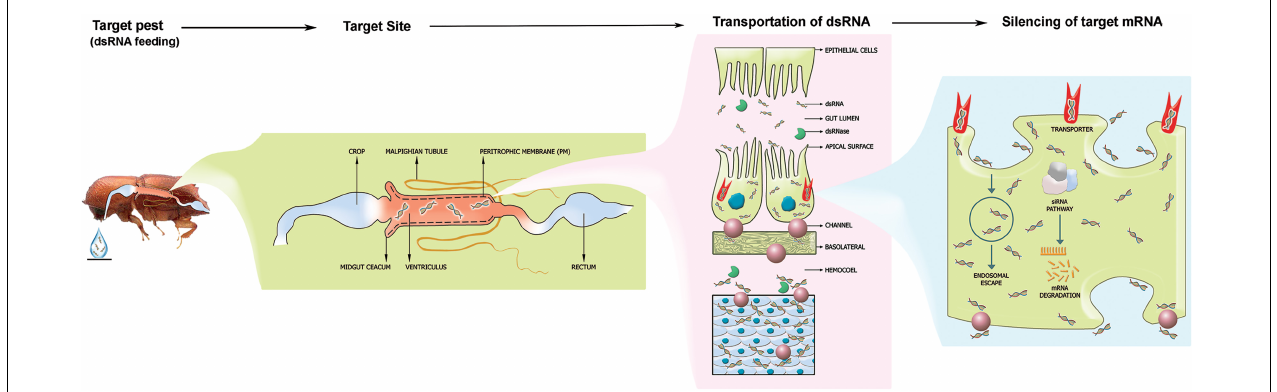
FIGURE 1 | The fundamental mechanism of RNAi from a coleopteran pest control standpoint. The target pest is feeding on the species-specific, gene-specific dsRNA droplet. After ingestion, the dsRNA will reach the midgut and passes through the peritrophic membrane. Subsequently, the dsRNA will be up-taken by the gut epithelial cells through the scavenger receptor-mediated endocytosis pathway and the transmembrane Sid-1 channel protein-mediated pathway. Further, the dsRNA is exported to hemocoel and fat bodies connected all over the body. The siRNA mechanism will be activated and triggers gene silencing upon dsRNA uptake by cells. Endosomal escape of the silencing signal resulting in RNAi efficiency within coleopteran pest induces RNAi